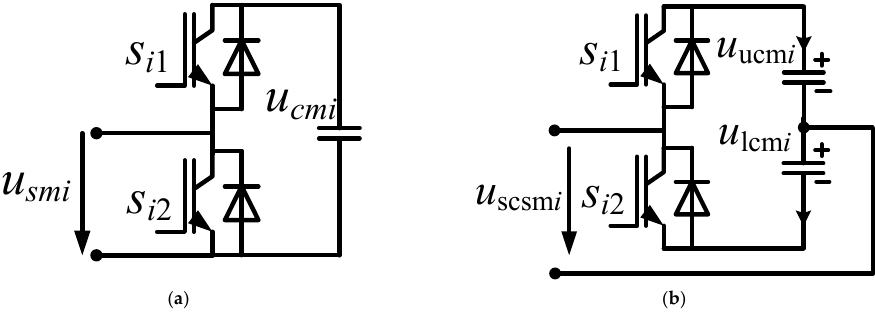
Figure 3. SM of the proposed hybrid MMC. ( a ) HBSM. ( b ) SCSM.